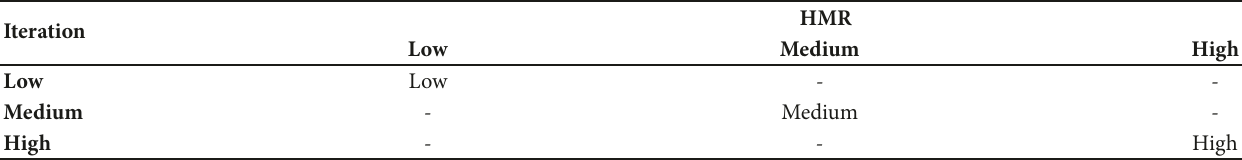
Table 4: Rules for the fuzzy systems (FHS, IT2FHS, and